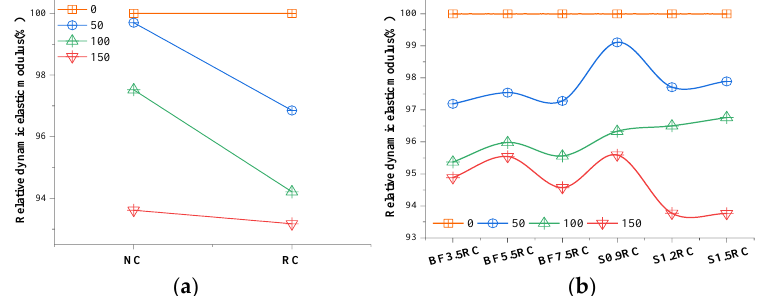
Figure 4. Comparison of relative dynamic elastic modulus. ( a ) NC and RC. ( b ) Fiber-only recycled concrete.